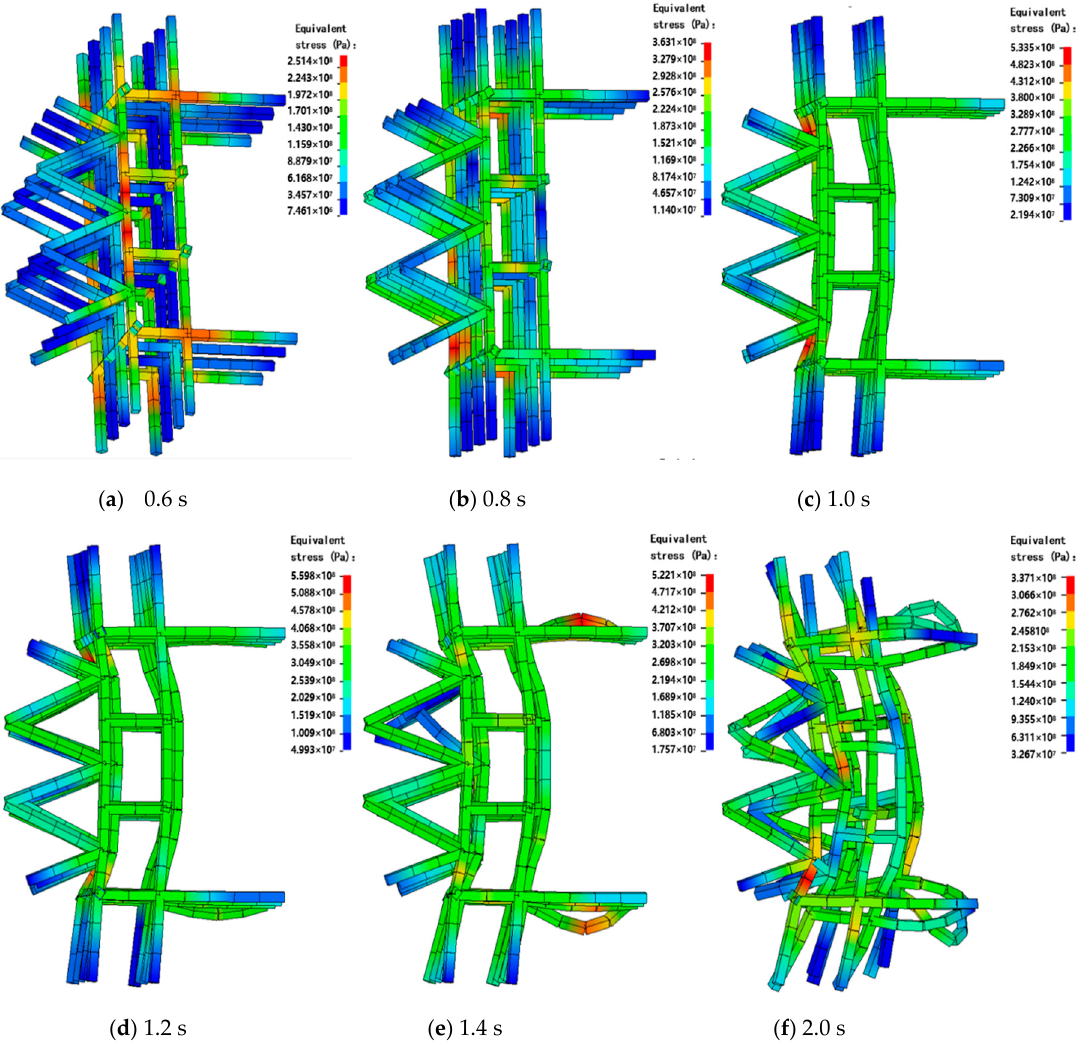
Figure 33. Deformation and Equivalent stress nephogram of the supporting element at 0° forward collision.